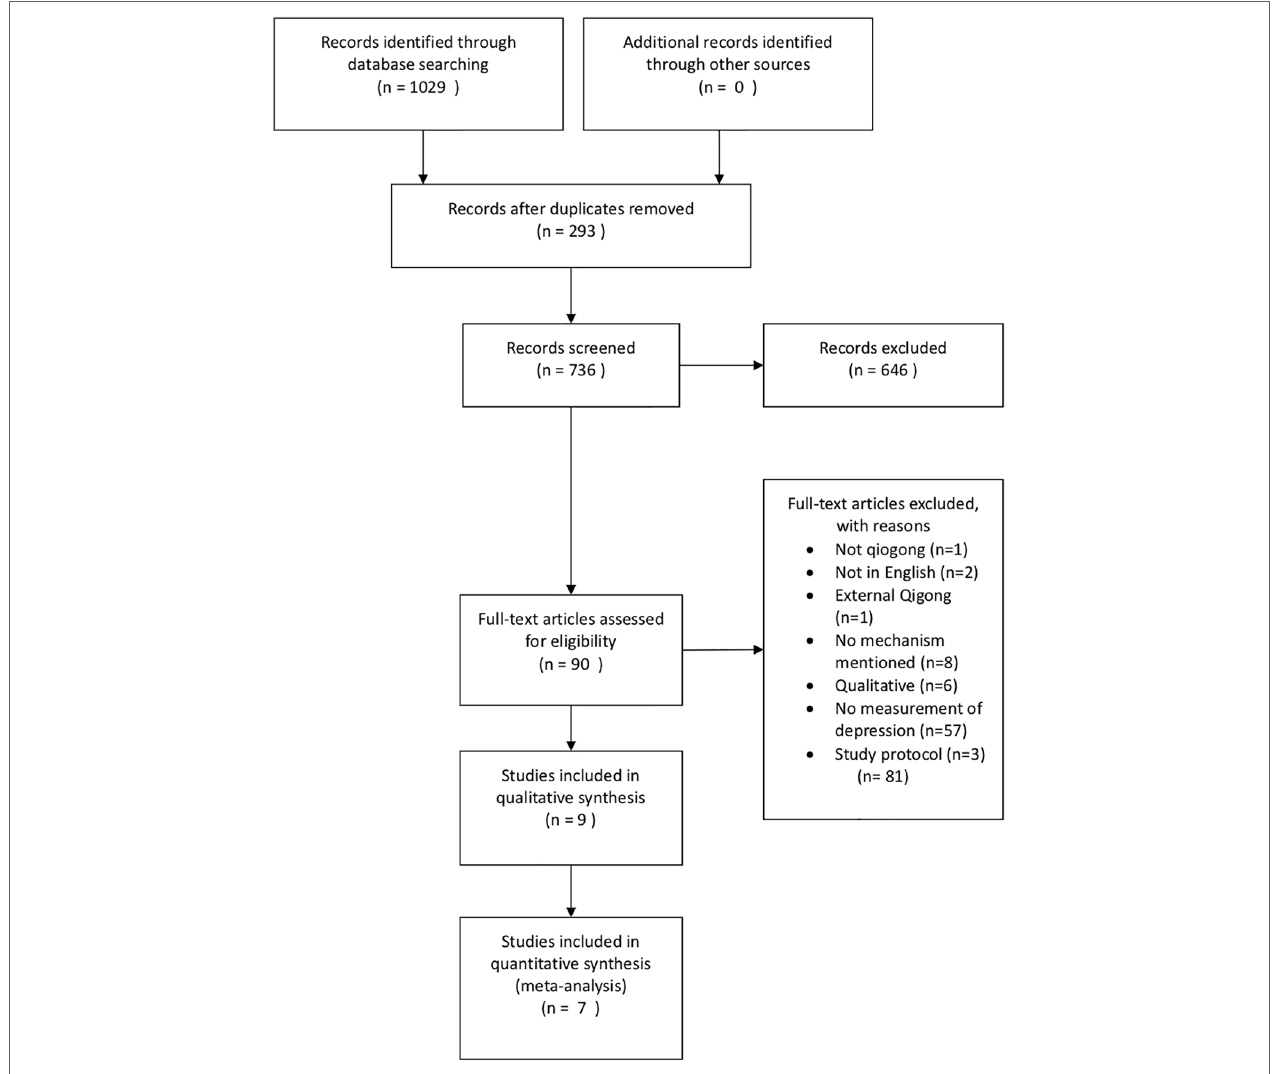
FiGURe 1 | PRISMA flow diagram. Seven studies were included in the meta-analysis for depression and four studies were included in the meta-analysis for blood